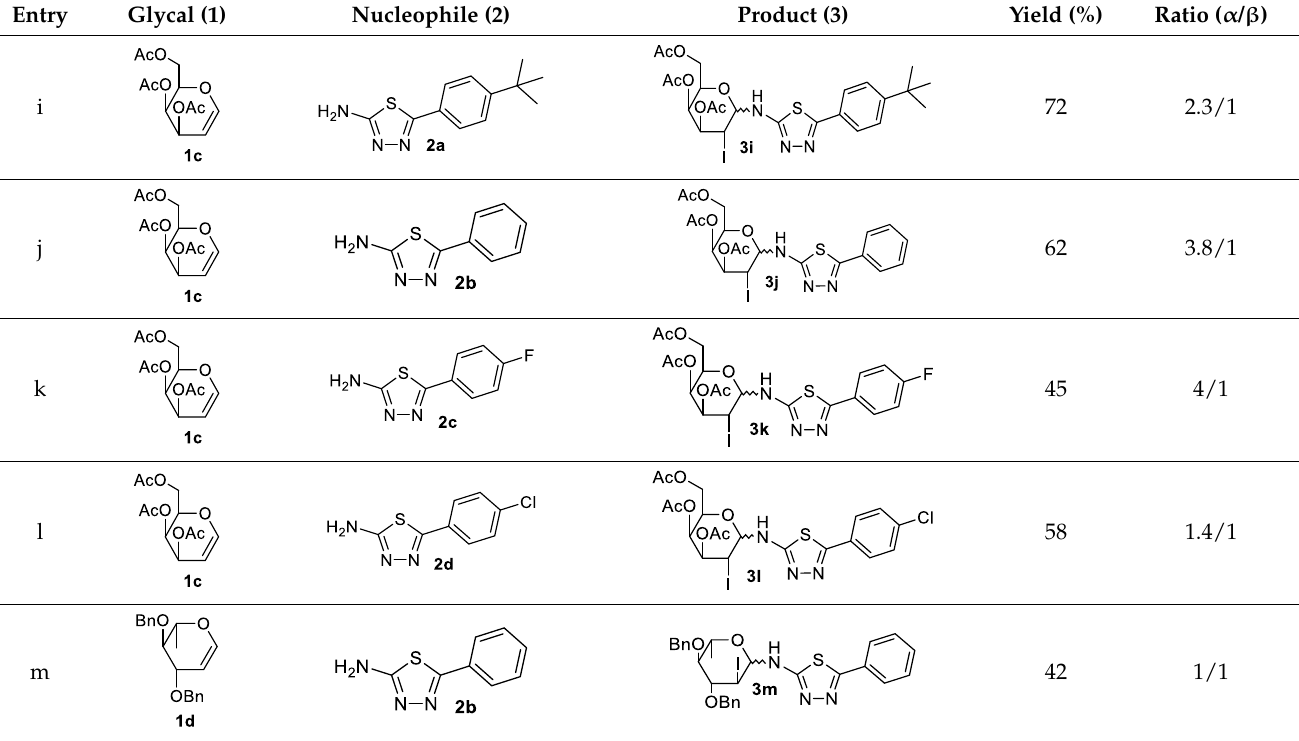
Table 2. Iodoamination of selected glycals.